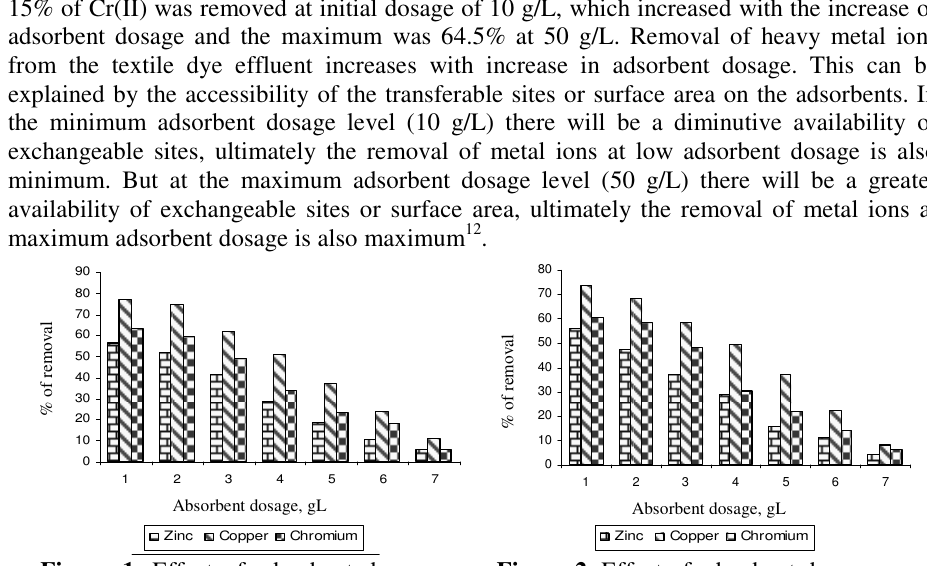
Figure 2. Effect of adsorbent dosage on the removal Zn(II), Cu(II) and Cr(VI) by neem leaves powder. Condition: T = 23 o C and t = 60 minutes